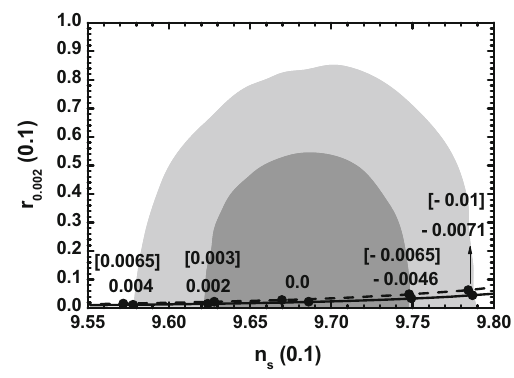
Fig. 2 The same as Fig. 1 but for K = K 1 (dashed line) and K = K 2 or K 3 (solid line) with the n values indicated on the curves (the n values in squared brackets correspond to K = K 1 ) for K = K 1 R , whereas for K = K 2 R we